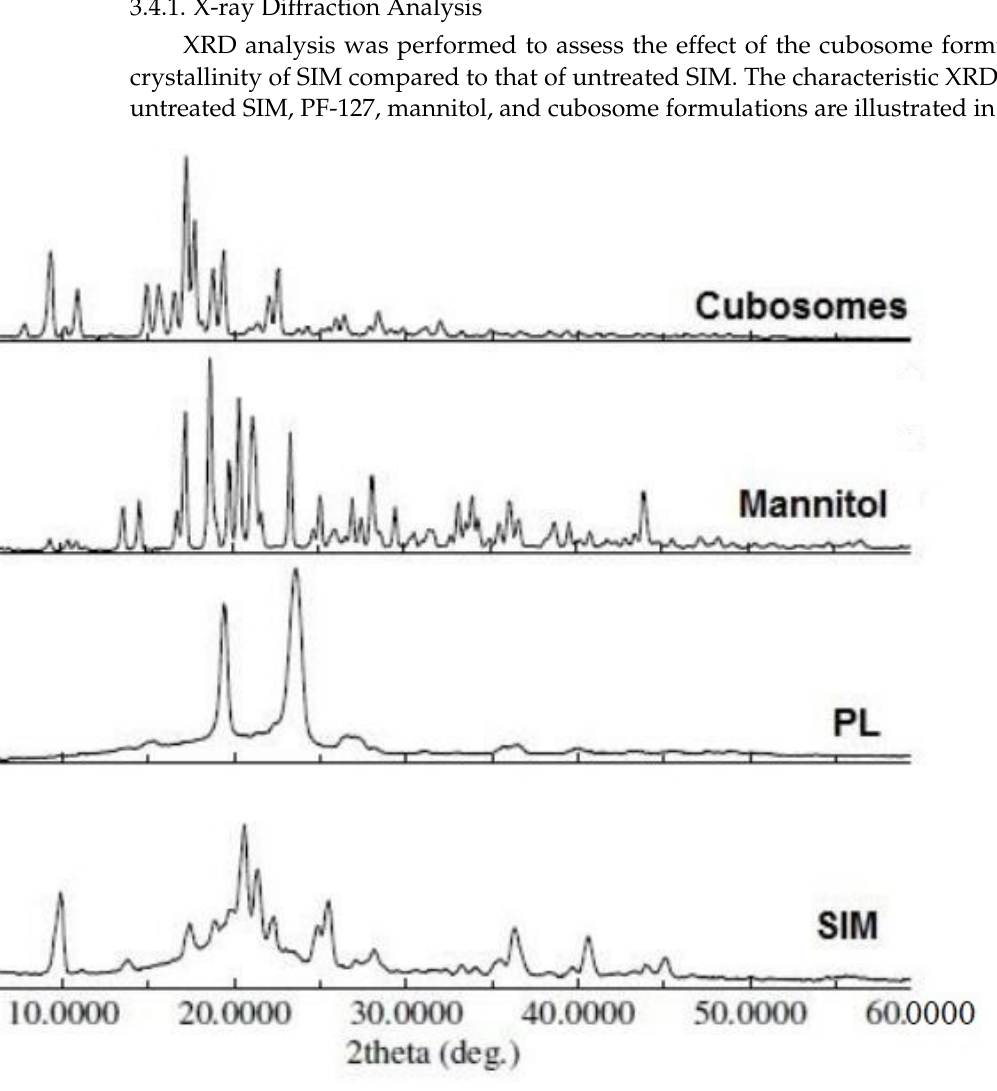
Figure 2. XRPD spectra of SIM, PF-127, mannitol, and SIM-loaded